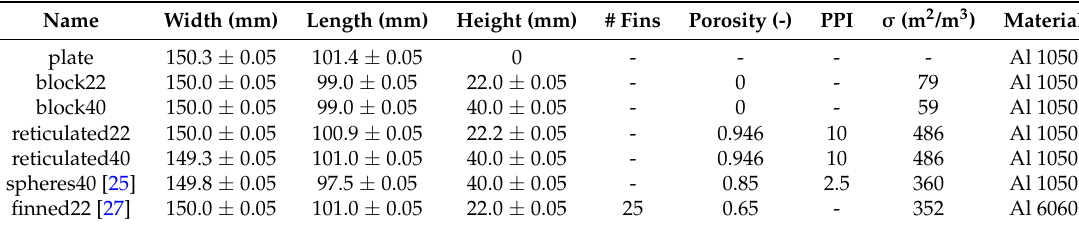
Table 1. Overview of the test